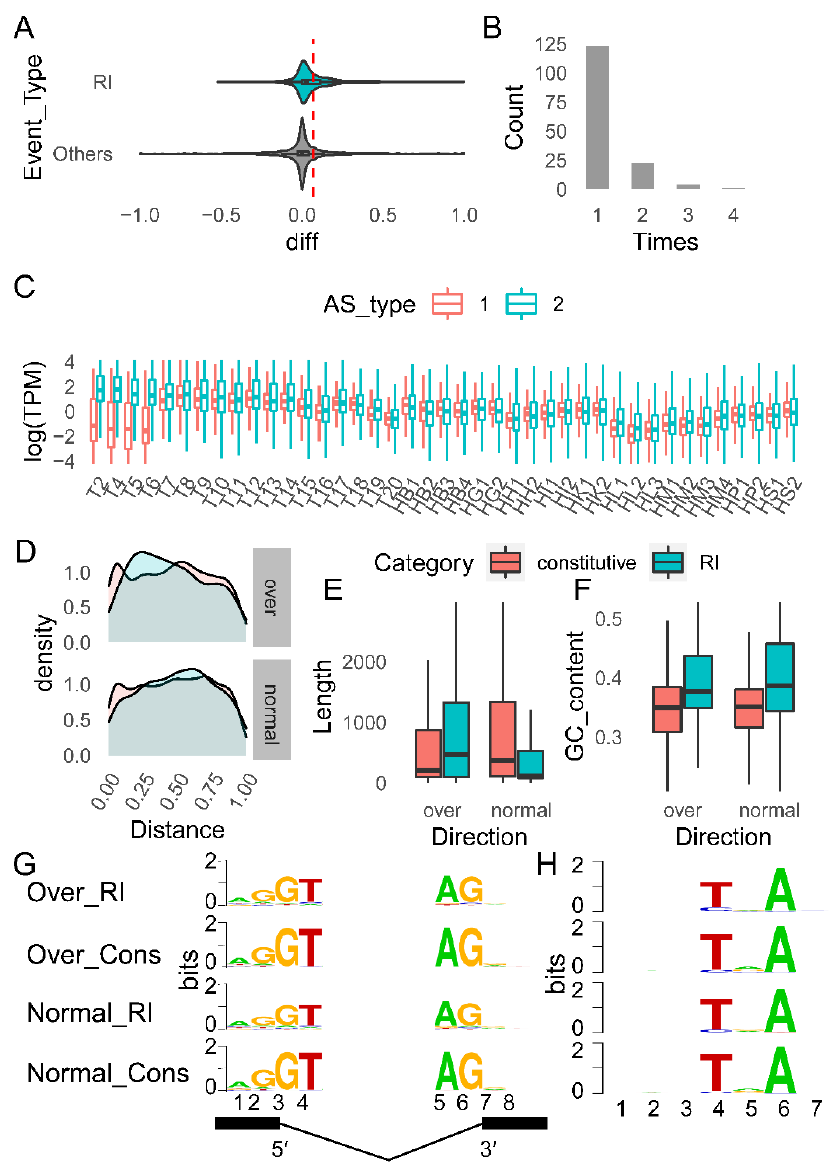
Figure 7. The distinguishing features of the transition from T6 (Dome) to T7 in the RI alternative splicing (256 cells). ( A ) The difference between the Ψ values of RI events ( Ψ (T7) − Ψ (T6)) exhibited an obvious right-skewed distribution. The right side of the red dotted line (0.07), which was classified as an “over” event (which will be referred to as “over” later), and the left side of the line, which was defined as a “normal” event (which will be referred to as “normal” hereafter); ( B ) The total number of RI events that have taken place in a gene; ( C ) The expression ratio of the two different splicing forms that have taken place in RI events. The transcripts with the intron kept are denoted by the form “1,” while the transcripts with the intron spliced out are denoted by the form “2.”; ( D ) The position distribution of alternative introns (red) and constitutive introns (blue) on the gene (relative to the transcriptional start site); ( E ) The differences in GC content between alternative introns and constitutive introns; ( F ) The differences in length between alternative introns and constitutive introns; ( G ) The motif of the splice site. ( H ) Motifs of branch-point sequences are also referred to (BPS). Alternative introns of “over” transcripts are referred to as “Over_RI,” while constitutive introns of “over” transcripts are referred to as “Over_Cons.” Similarly, alternative introns of “normal” transcripts are referred to as “Normal_RI,” while constitutive introns of “normal” transcripts are referred to as “Normal_Cons”.